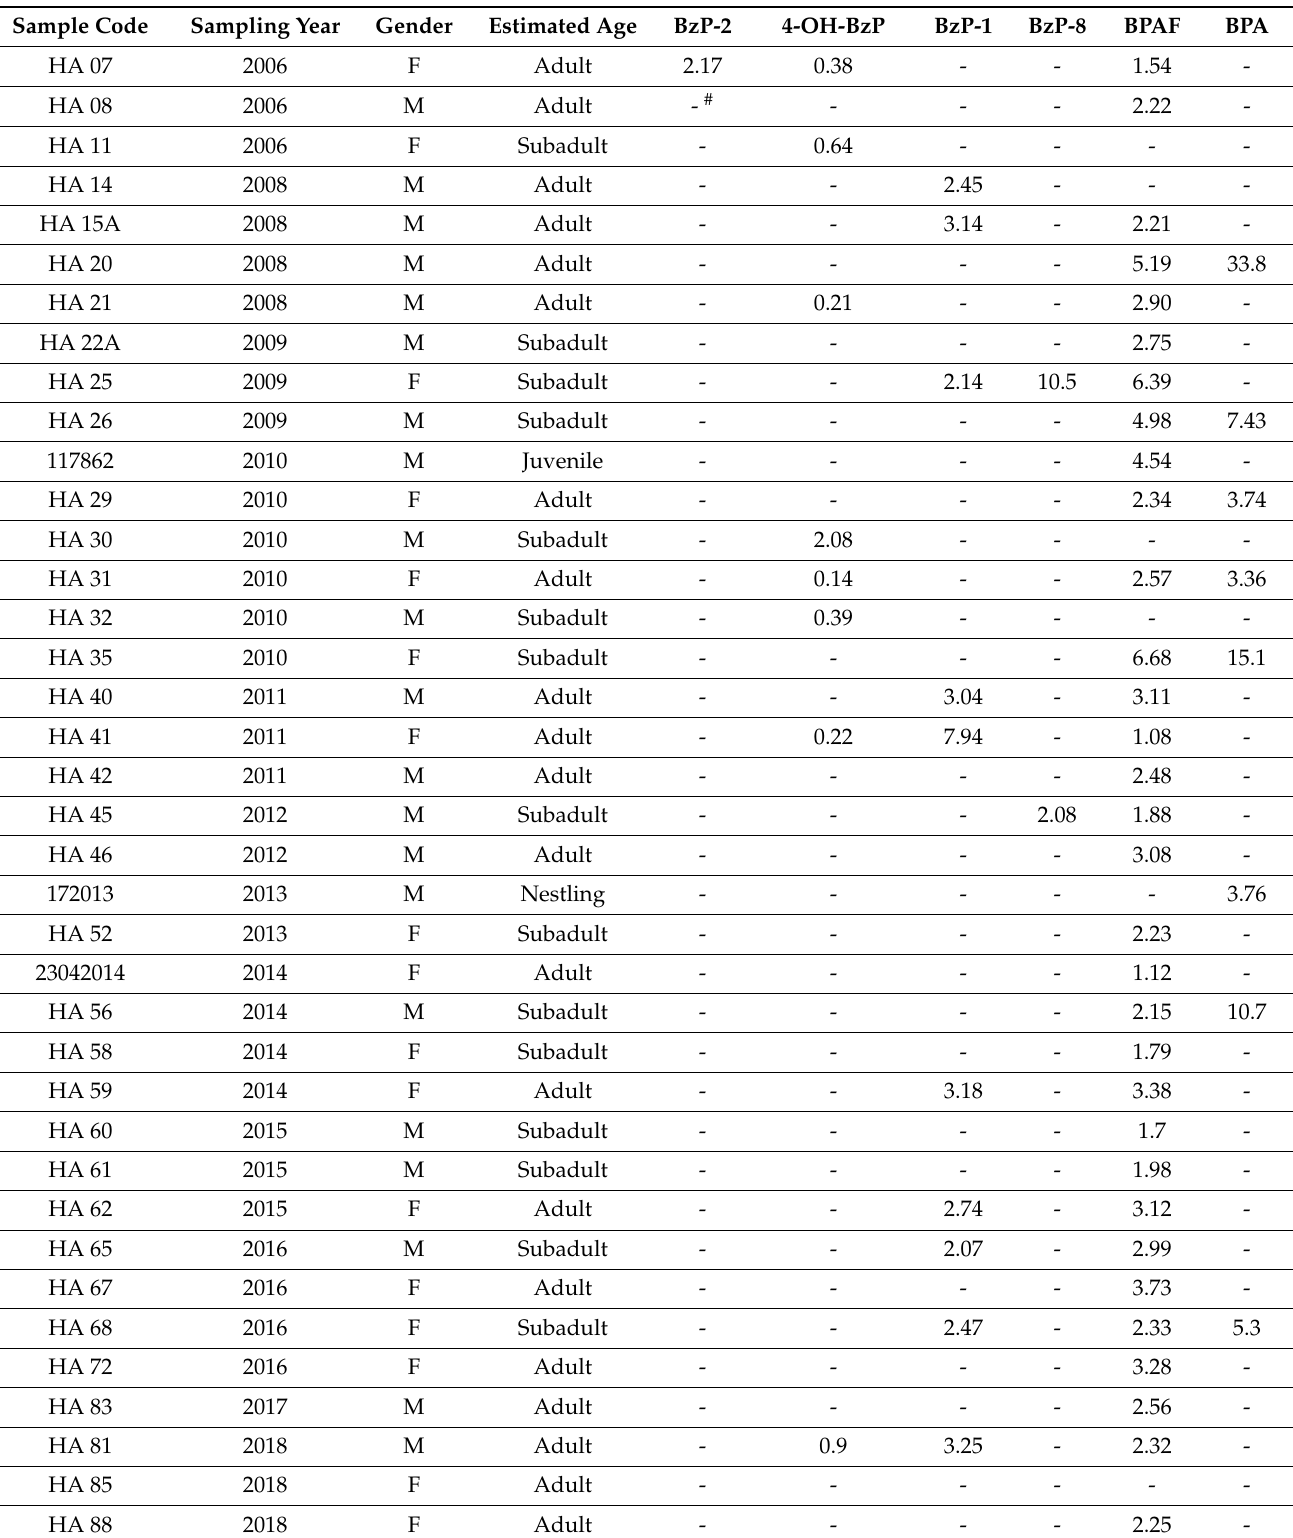
Table 2. Concentrations in ng/g w.w. of the detected target compounds in the livers from the white-tailed eagles ( Haliaee- tus albicilla ) ( n =